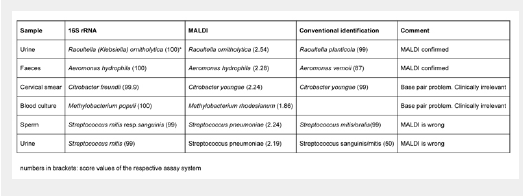
Comparative analysis of bacterial identification including MALDI, conventional identification and 16S rRNA